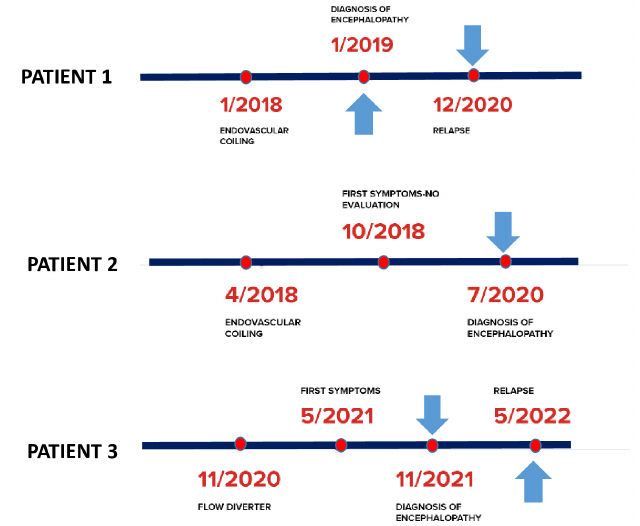
Figure 1. Timeline overview of three cases. Arrows suggest steroid treatment.